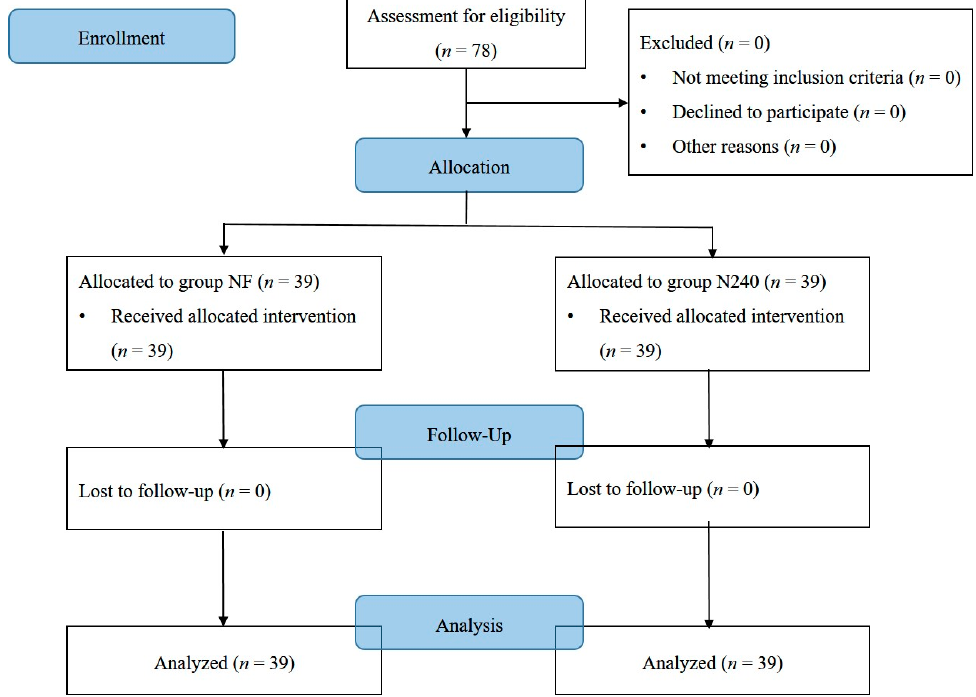
Figure 1. CONSORT diagram for patient recruitment. Group NF, group receiving nefopam-fentanyl polytherapy; Group N240, group receiving nefopam monotherapy.